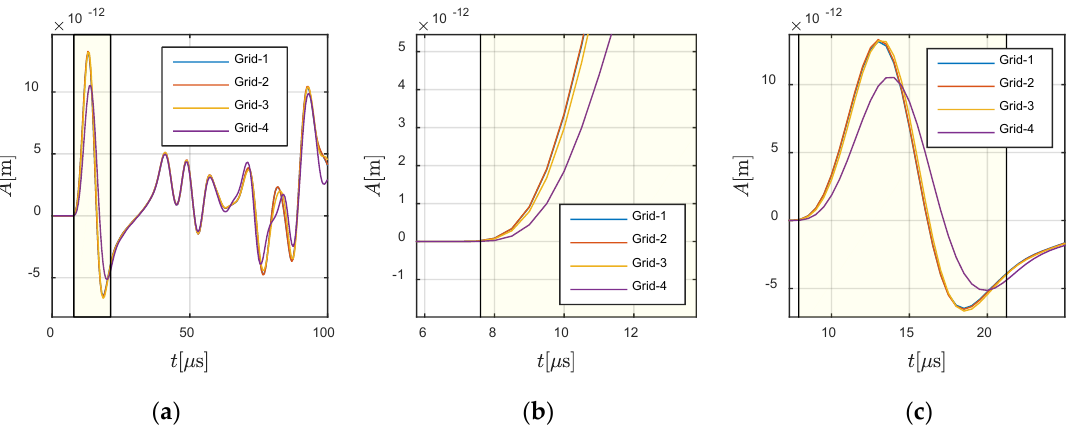
Figure 11. Responses in X- direction at − 0.0625 m and 0 m in the solid region: ( a ) global view and ( b , c ) local views. The highlighted part defines the theoretical wavefront and duration of the P-wave.